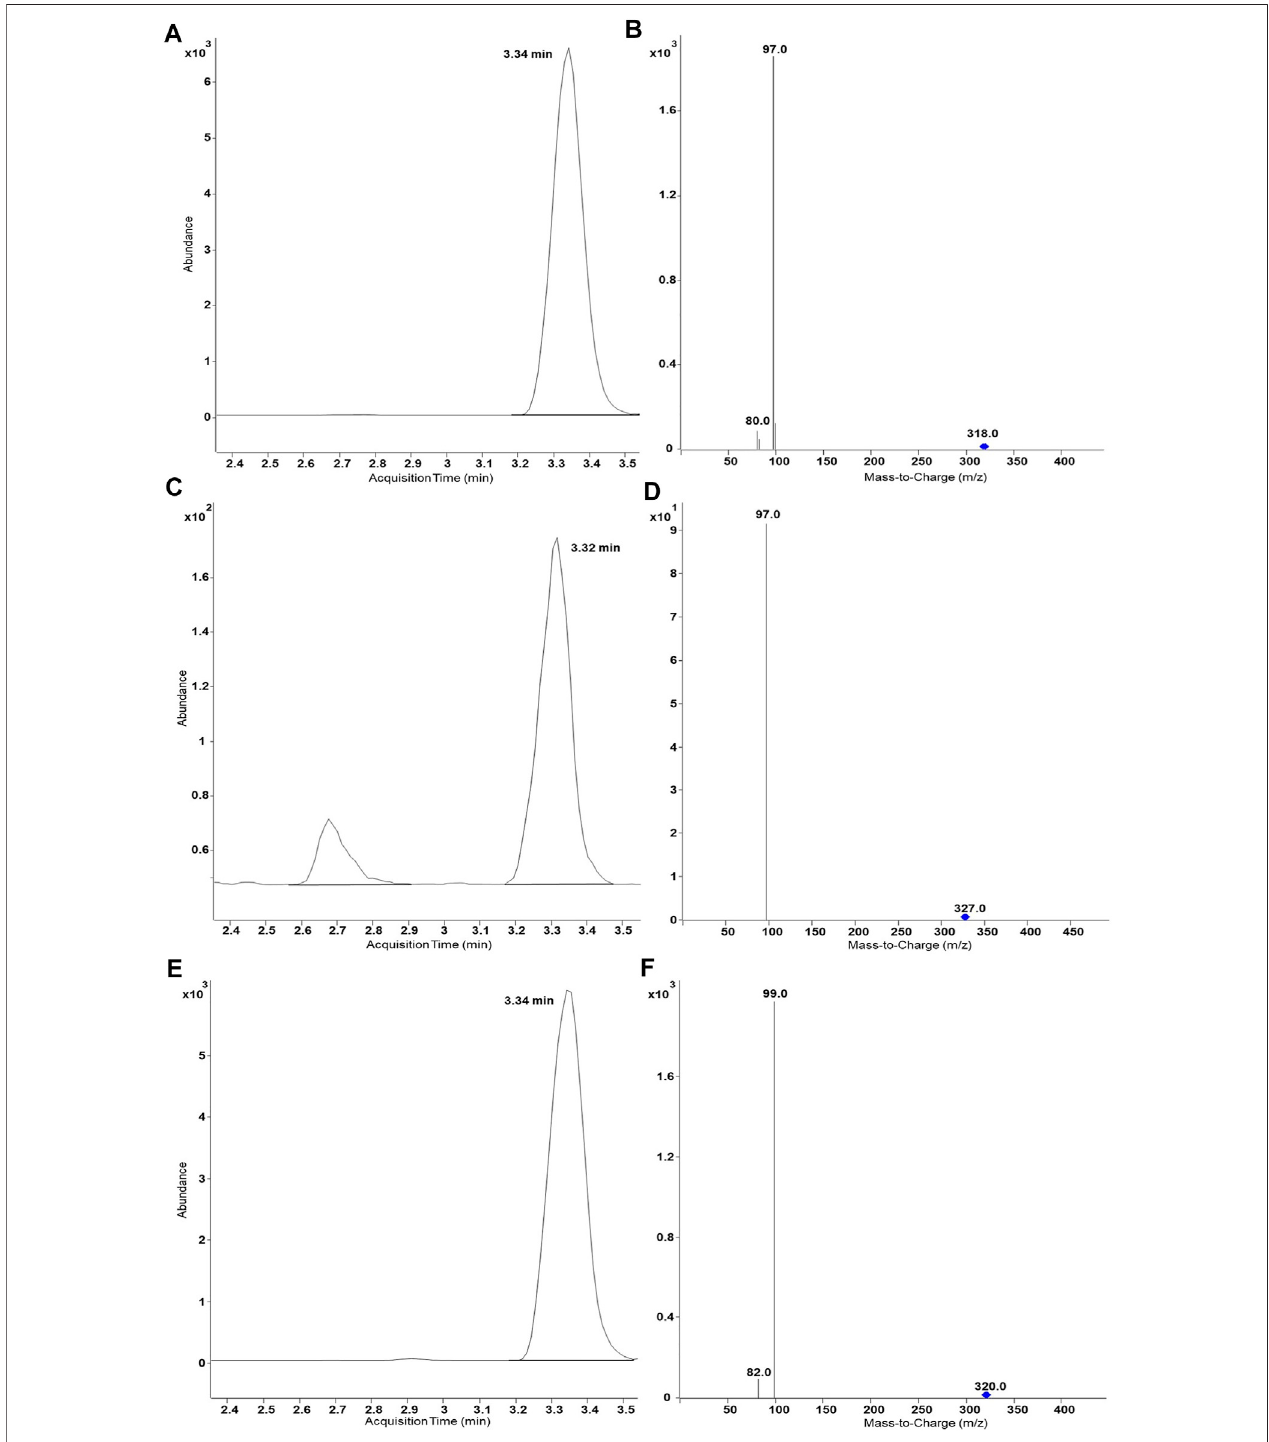
FIGURE5| UHPLC-MS/MSresultsofbiosynthesisofSASU,D 9 -SASU,andSA- 34 S-SUbySULT1A3(YN20).ProductionspectrageneratedinESI − aredominated bythefragmentHSO 4 − (96.9)orH 34 SO 4 − (98.9). (A) ChromatogramofSASUshowsiontransition m/z 318.0 → 97; (B) MRMtransitionsinSASUassay( m/z 318.0 → 97.0 and 318.0 → 80.0); (C) Chromatogram of D 9 -SASU shows m/z 327.0 → 97.0; (D) MRM transitions in D 9 -SASU assay ( m/z 327.0 → 97.0 and 327.0 → 79.8); (E) Chromatogram of SA- 34 S-SU shows m/z 320.0 → 99.0; (F) MRM transitions in SASU assay ( m/z 320.0 → 99.0 and 320.0 → 82.0).